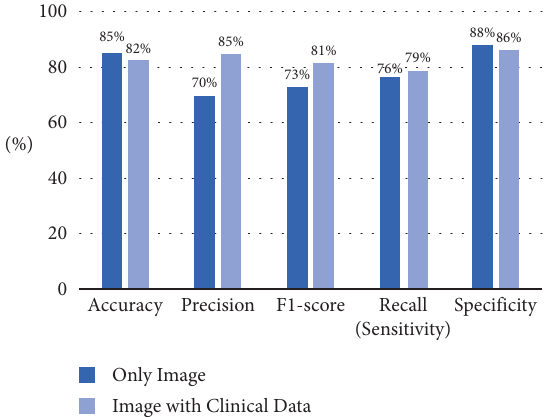
Figure 8: Te performance of the diagnosis model while con- sidering only image and fusion